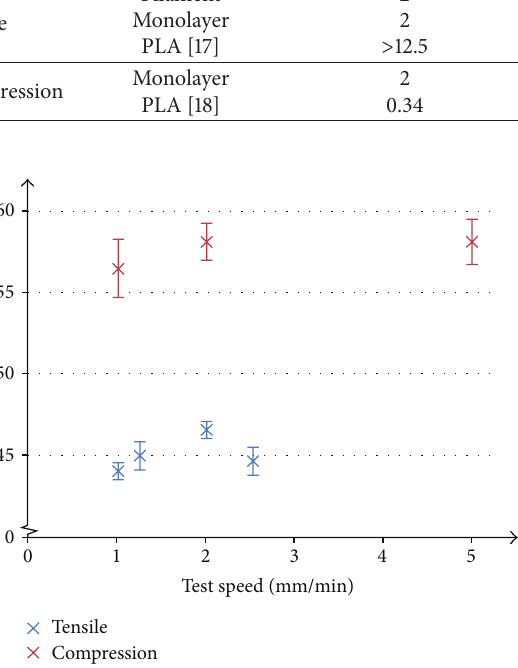
Figure 8: AM monolayer tensile and compressive strength at diffe- rent test